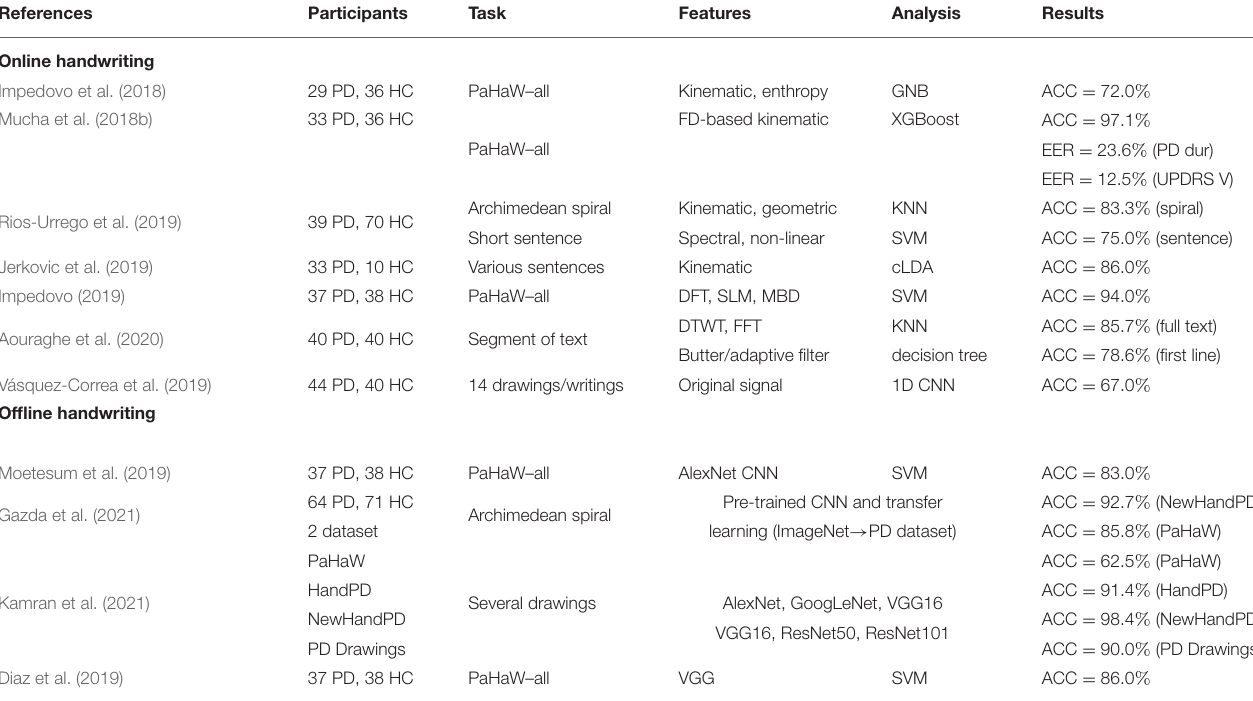
TABLE 1 | Overview of the related works.